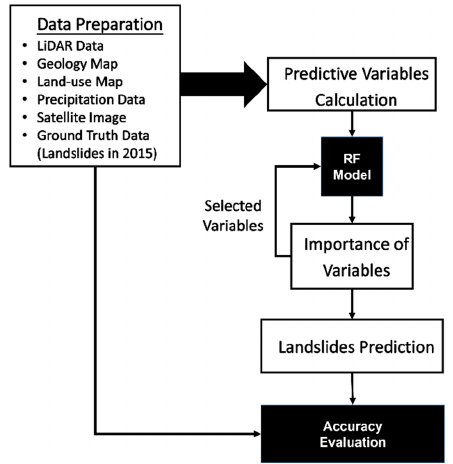
Figure 2. Flowchart of the methodology used for landslide prediction in the study region.